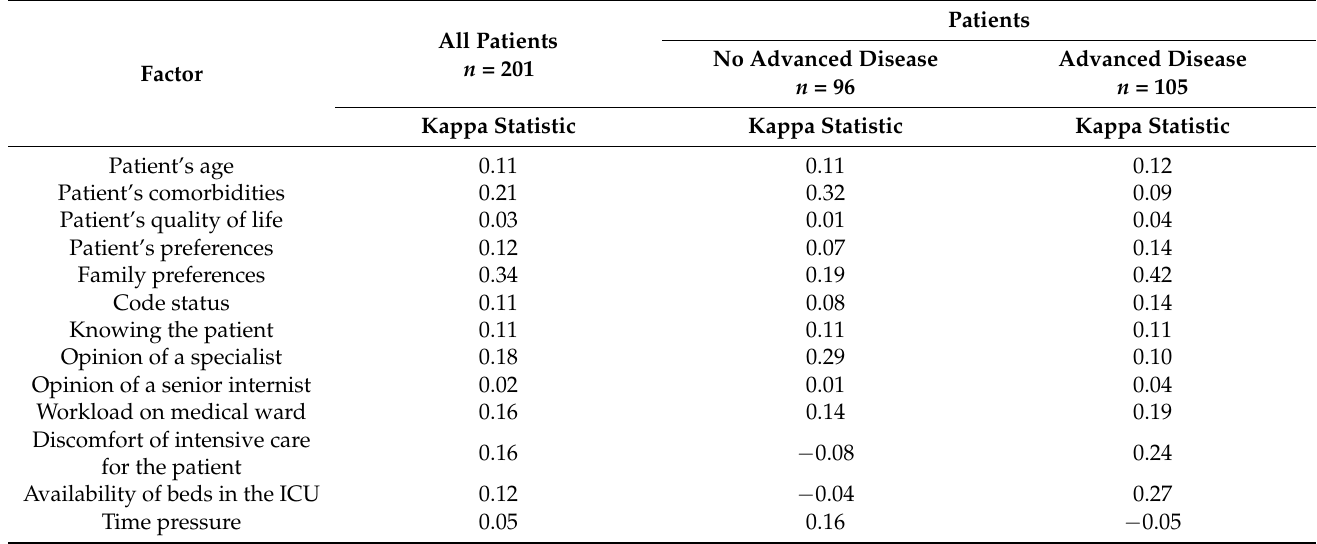
Table 2. Agreement beyond chance between intensivist and internist about the influence of specific factors on the admission decision (dichotomized assessments), in 201 patients, and for patients with and without advanced